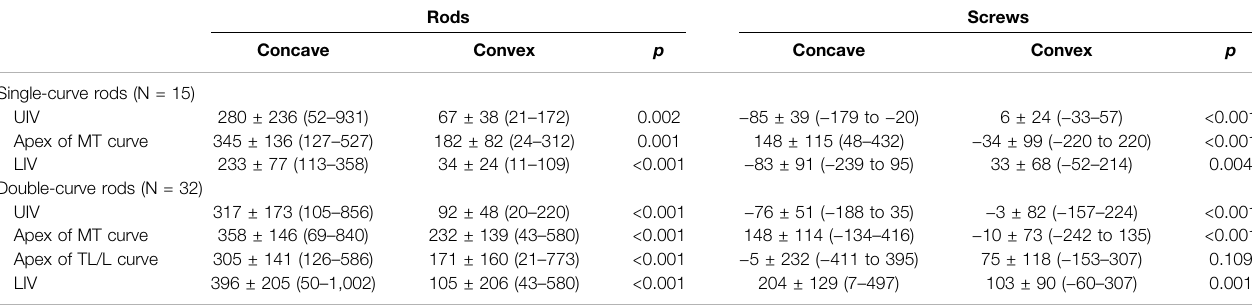
TABLE 7 | Estimated rod stress (MPa) and screw forces (N) in simulation model. Rods Screws Concave Convex p Concave Convex